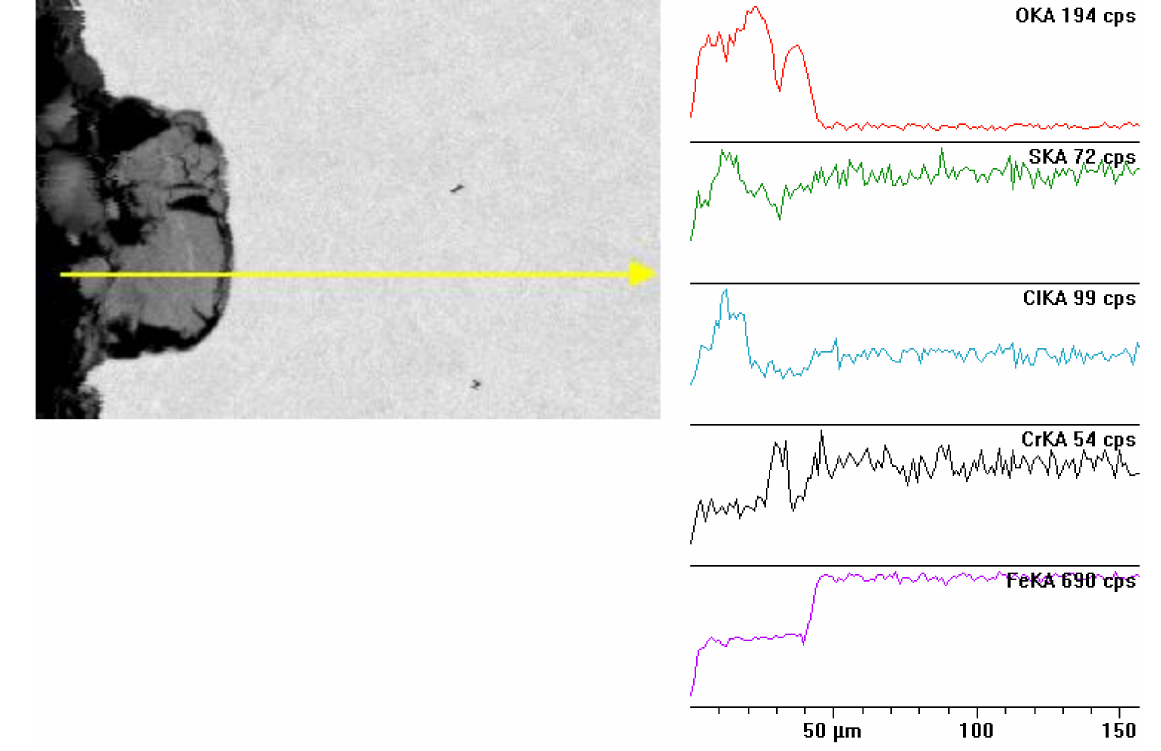
Figure 10. Cross section and linear cross scan of the elements in L80-1 steel at 80 ◦ C.